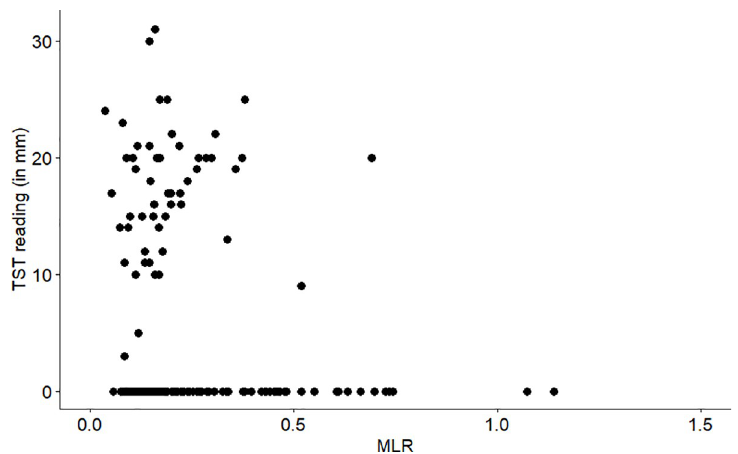
Fig 1. Scatterplot of MLR and quantitative TST values (in mm) among all 171 participants. MLR = monocyte-to- lymphocyte ratio; TST = tuberculin skin test.